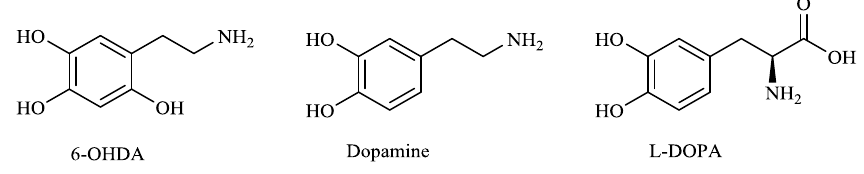
Figure 1. Chemical structures of 6-hydroxydopamine (6-OHDA), dopamine, and L-3,4- dihydroxyphenylalanine